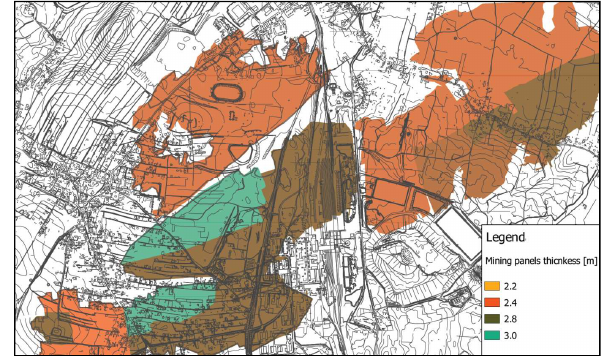
Figure 3. Faults and buffer zones around faults.